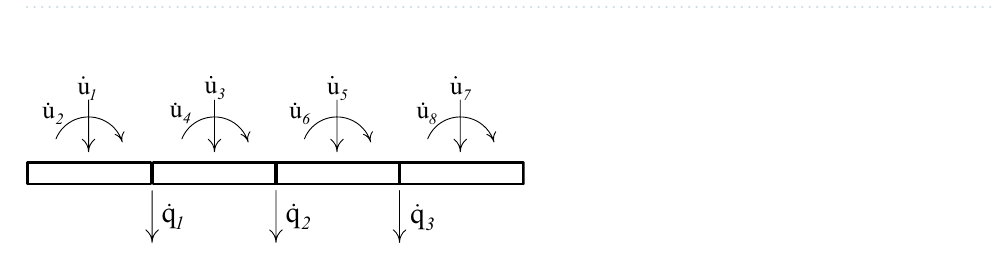
Figure 3. Continuous mass system having centroidal velocities ˙ u related to inertia forces and independent nodal velocities ˙ q .